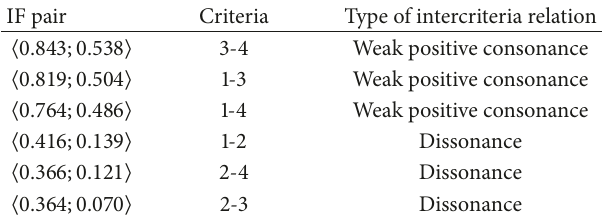
Table 5: Relations among the criteria.